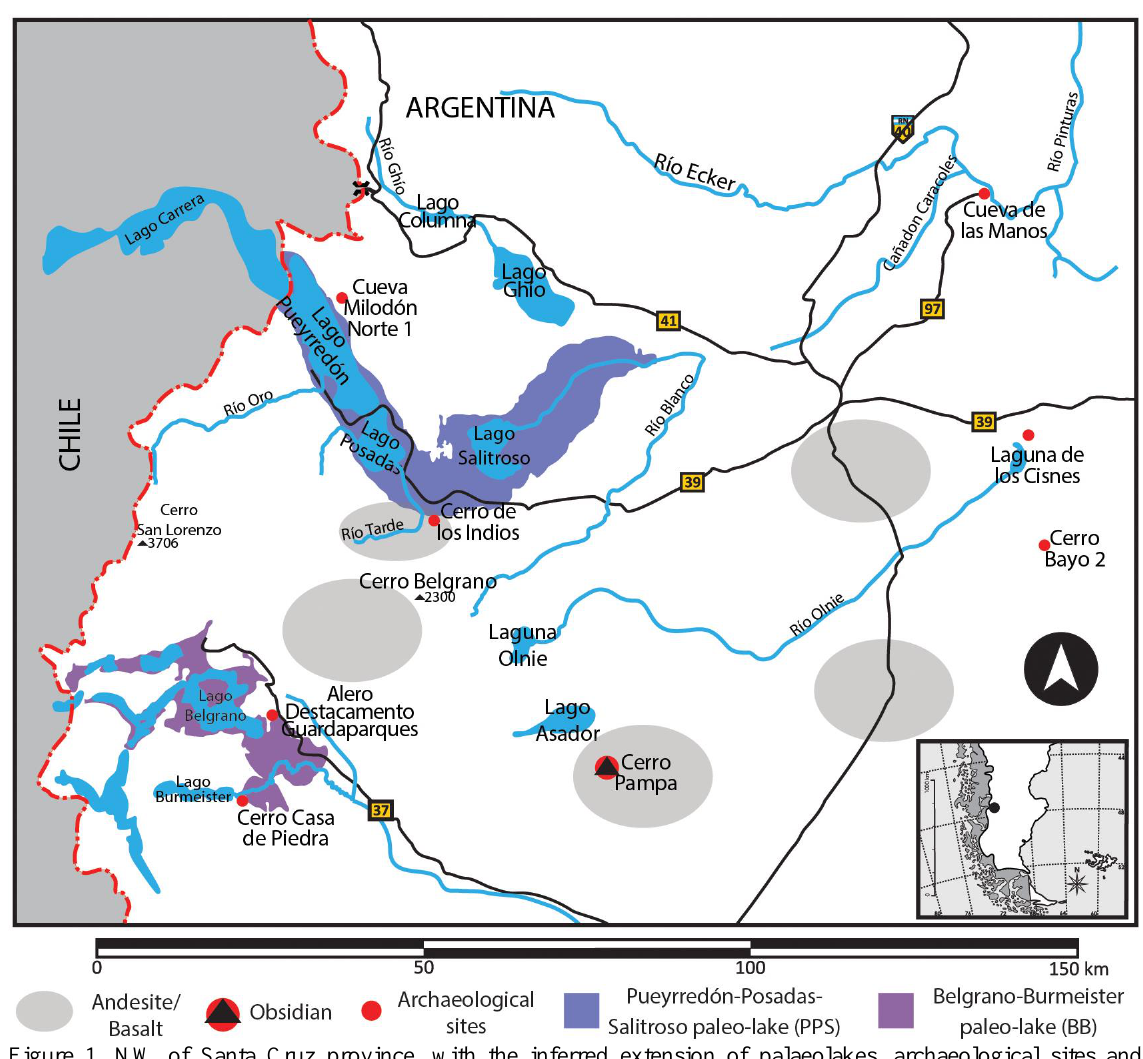
Figure 1. NW of Santa Cruz province, with the inferred extension of palaeolakes, archaeological sites and andesite and obsidian sources mentioned in the